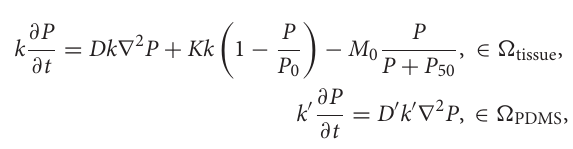
Frontiers in Physiology |